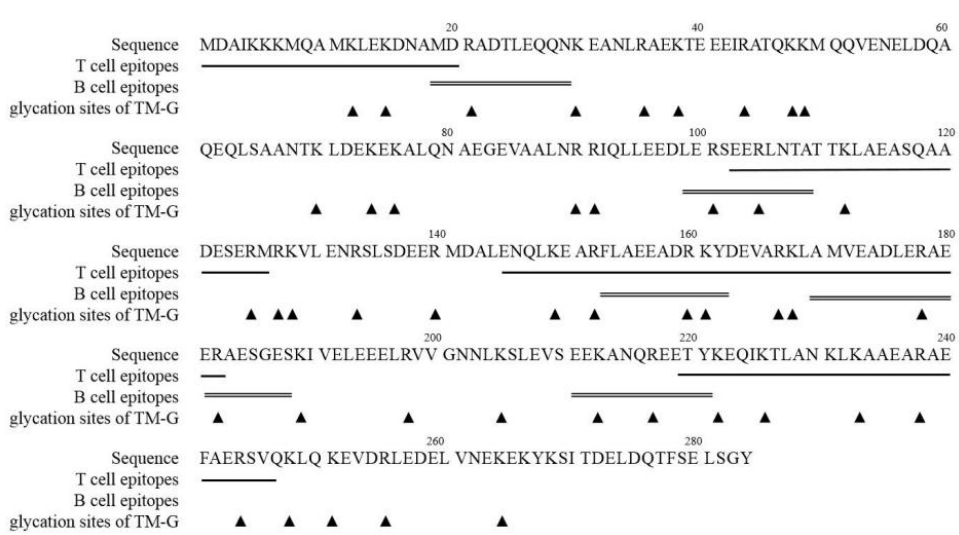
Figure 6. The modification analysis of the epitopes of TM-G. B cell epitopes of TM that have been identified, T cell epitopes of TM were predicted by prediction system. The T cell (underlined) and B cell (double underlined) reactive regions was compared with glycation sites of TM-G (marked by triangle).